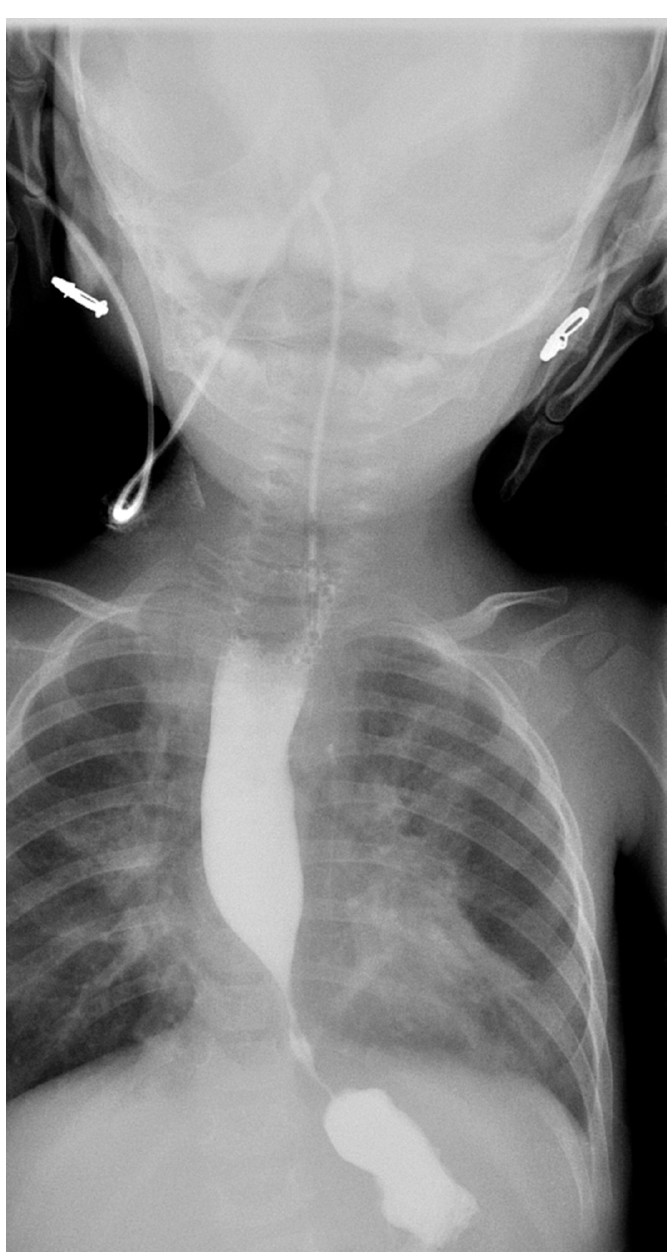
Figure 2. Barium swallow showing an obstruction at the lower end of the esophagus with proximal dilatation and pooling of barium.